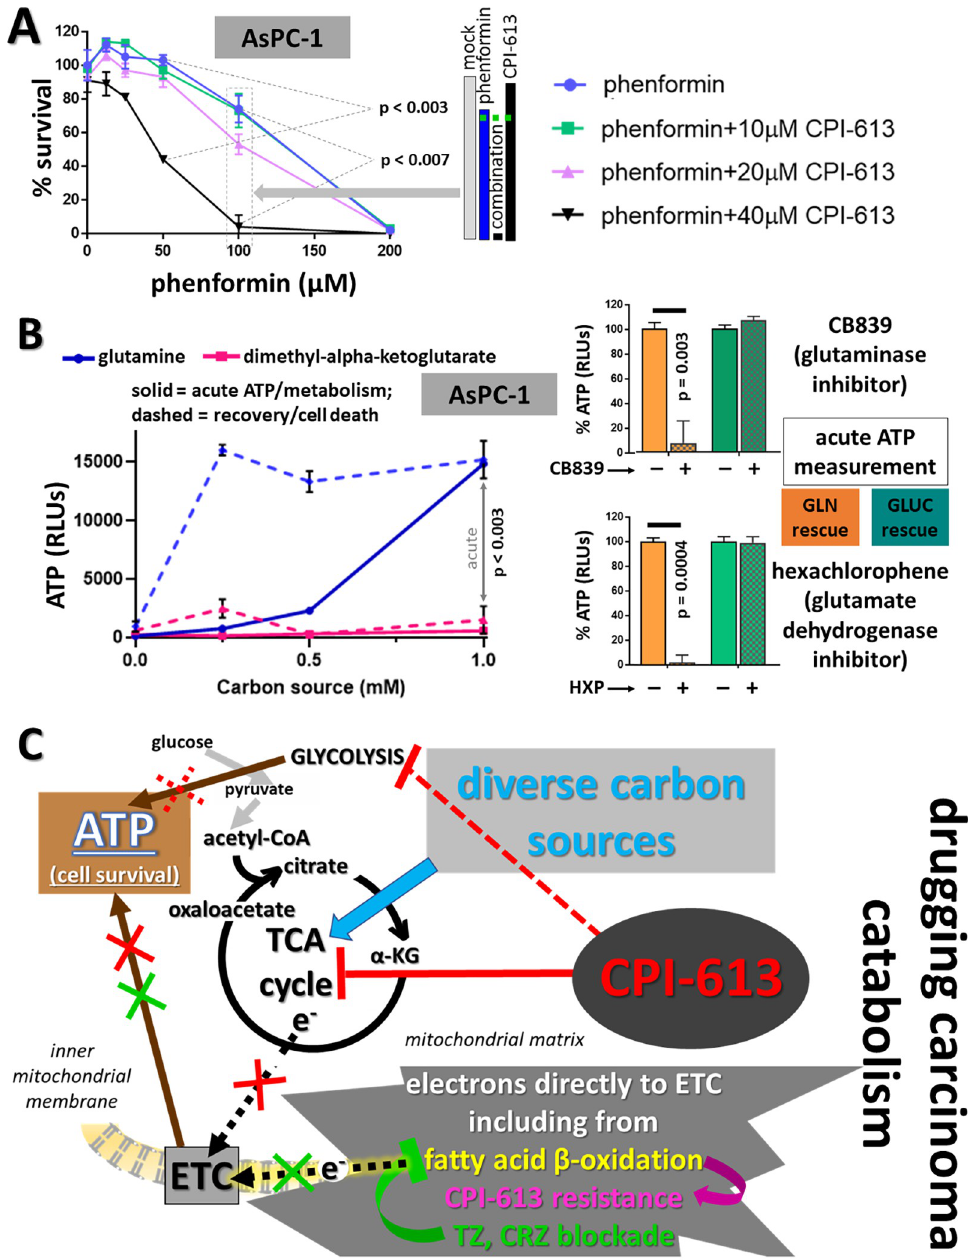
Fig 4. Targeting carcinoma ETC and glutamine catabolism modulates CPI-613 sensitivity; graphic depiction of theory of regulation of CPI-613 sensitivity by available nutrients. A: Complex I inhibitor phenformin sensitizes AsPC1 to CPI-613 killing . AsPC1 cells (CPI-613 resistant) were treated for 20hrs as indicated, followed by 24hrs of CM/ns recovery to assess cell death (Materials and Methods; legend to Fig 1A). Shown are p values for differences between indicated phenformin concentrations alone and in presence of 40 μ M CPI-613. Bar graph illustrates the example of an enhancement effect in boxed points set as indicated by grey block arrow. The dashed green line indicates the expected effects if the two agents act independently. B. GLN protects from CPI-613 effects in AsPC1 cells , while its immediate downstream metabolic product does not . All experiments were done in the presence of 50 μ M GPi and 60 μ M CPI-613 to reduce contributions from endogenous stores (as in Fig 3D). At left the acute measurements were done after 15hrs of drug exposure and cell death commitment measurements after 15hrs of drug exposure followed by 22hrs of CM/ns recovery (legend to Figs 1A and S1A). The cell-permeable dimethyl ester form of alpha-ketoglutarate robustly delivers alpha-ketoglutarate through cytosolic esterase action [55]. At right, effects on acute ATP levels (4.5 hours treatment) of the glutaminase inhibitor CB839 (0.33uM) or glutamate dehydrogenase inhibitor hexachlorophene (0.33uM) were